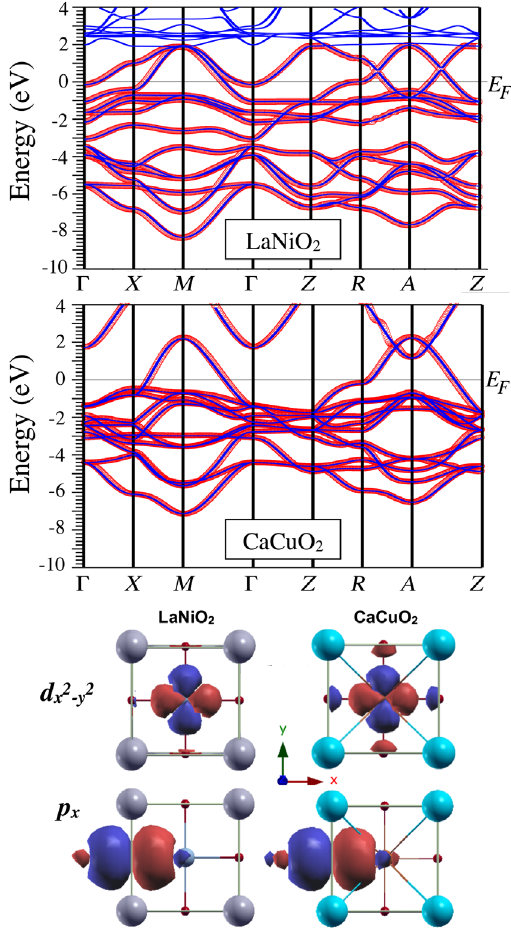
and p character for x x 2 − y 2